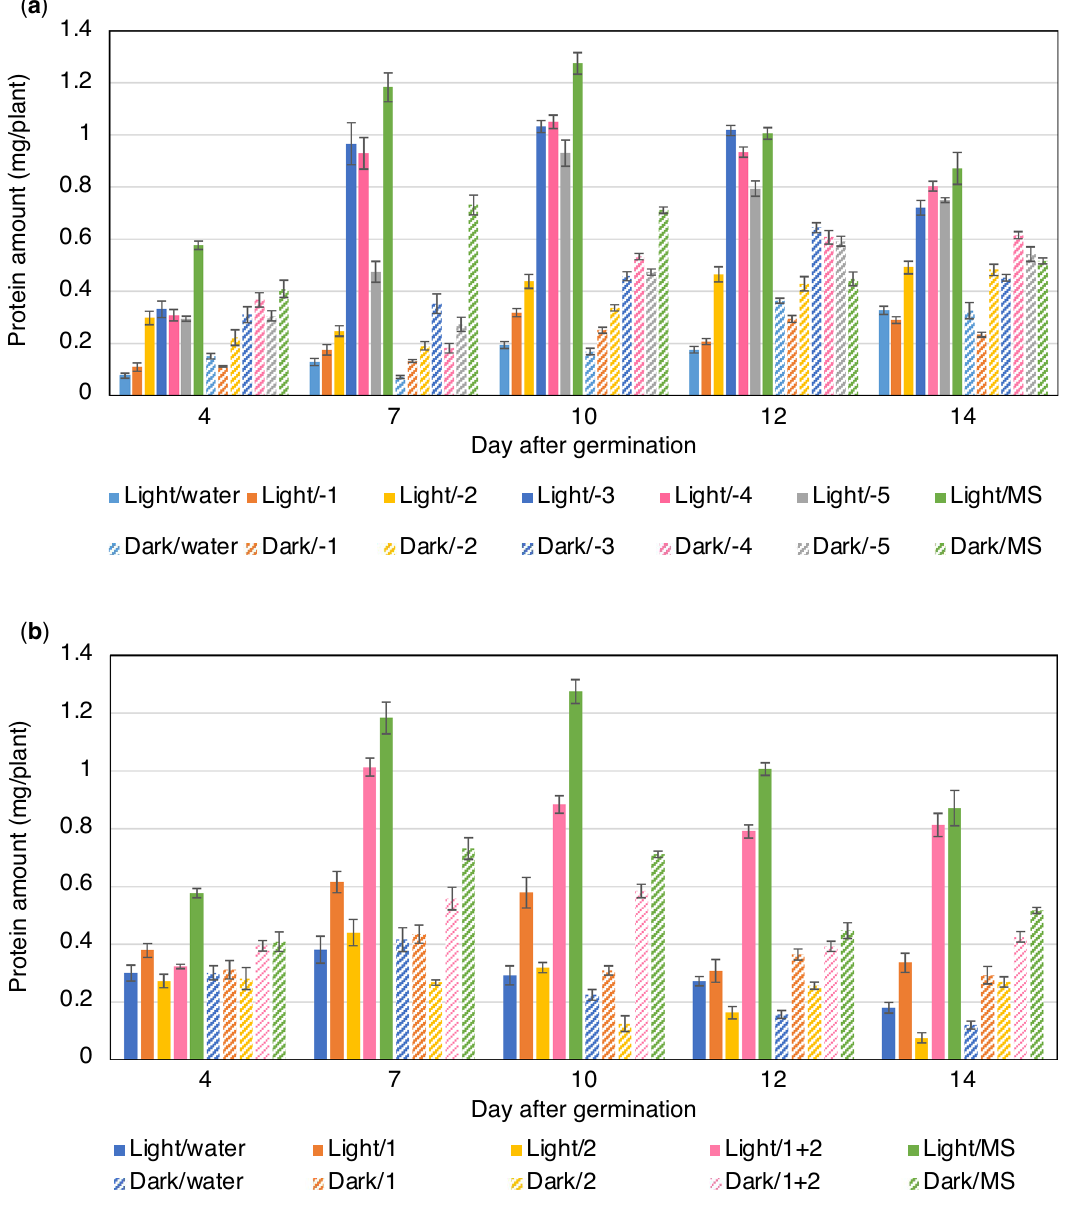
Figure 2. Protein production in rice seedlings supplemented with different combinations of the inorganic elements contained in the MS medium. ( a ) Total amount of soluble protein extracted from each seedling (n = 5) after supplementation with MS medium or MS medium variants lacking a specific group of inorganic components. Results of statistical analysis are shown in Supplementary Table S1. ( b ) Total amount of soluble protein extracted from each seedling (n = 5) after supplementation with group 1, group 2 or their combination. Results of statistical analysis are shown in Supplementary Table